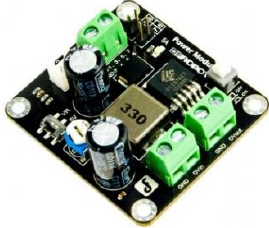
Figure 6. DFRobot 5-A Power Module DFR0205.